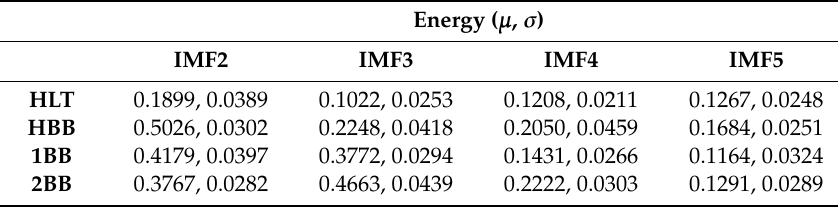
Table 4. Mean ( µ ) and standard deviation ( σ ) for the energy